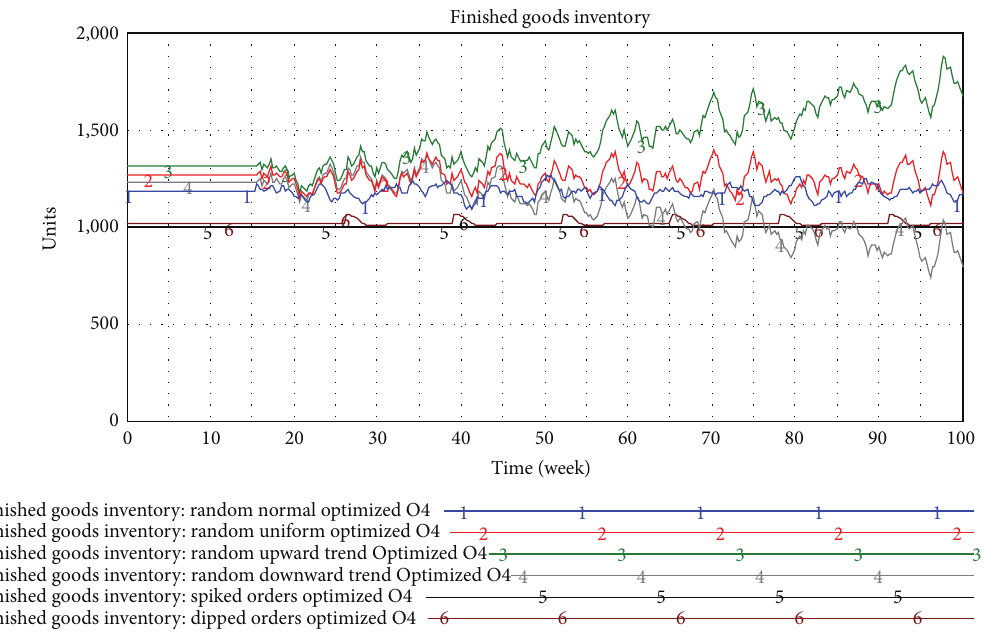
Figure 8: Improved Finished Goods levels for retailer with parametric optimization under composite objective including minimization of inventory